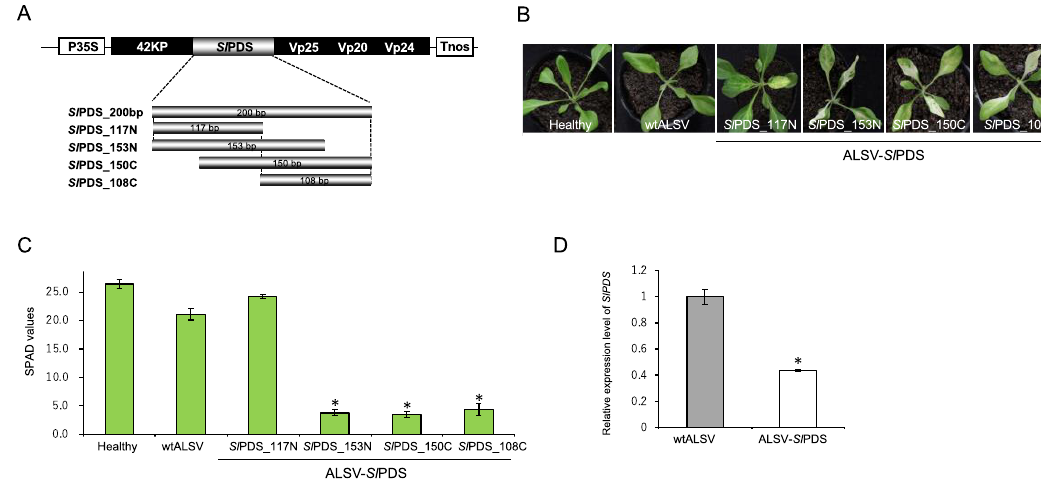
Figure 3. Virus-induced gene silencing (VIGS) of SlPDS gene in S. latifolia plants. ( A ) Schematic representation of ALSV- Sl PDS vectors used for VIGS. Four partial SlPDS fragments shown below, which differ in positions and length, were inserted into the artificial processing site of ALSV vector; ( B ) photographs of S. latifolia plants infected with ALSV- Sl PDS vectors at 20 dpi. Healthy represents a S. latifolia plant without any virus infection, and wtALSV represents a S. latifolia plant infected with wild-type ALSV vector without an SlPDS insert; ( C ) relative chlorophyll contents measured by the Soil Plant Analysis Development (SPAD) values in leaves infected with wtALSV and ALSV- Sl PDS vectors. SPAD values represent mean ± SE from three leaves of each plant ( n = 3 to 7). Asterisks indicate a significant difference between plants infected with wtALSV and those infected with each ALSV- Sl PDS vector at p < 0.001 (Student’s t -test); ( D ) quantitative reverse transcription PCR (RT-qPCR) analysis of SlPDS gene expression levels in plants infected with wtALSV, and those infected with ALSV- Sl PDS. The error bars represent the standard deviations of at least three plants normalized to the S. latifolia 18S ribosomal RNA gene. The asterisk indicates a significant difference between plants infected with wtALSV, and those infected with ALSV- Sl PDS at p < 0.001 (Student’s t -test).